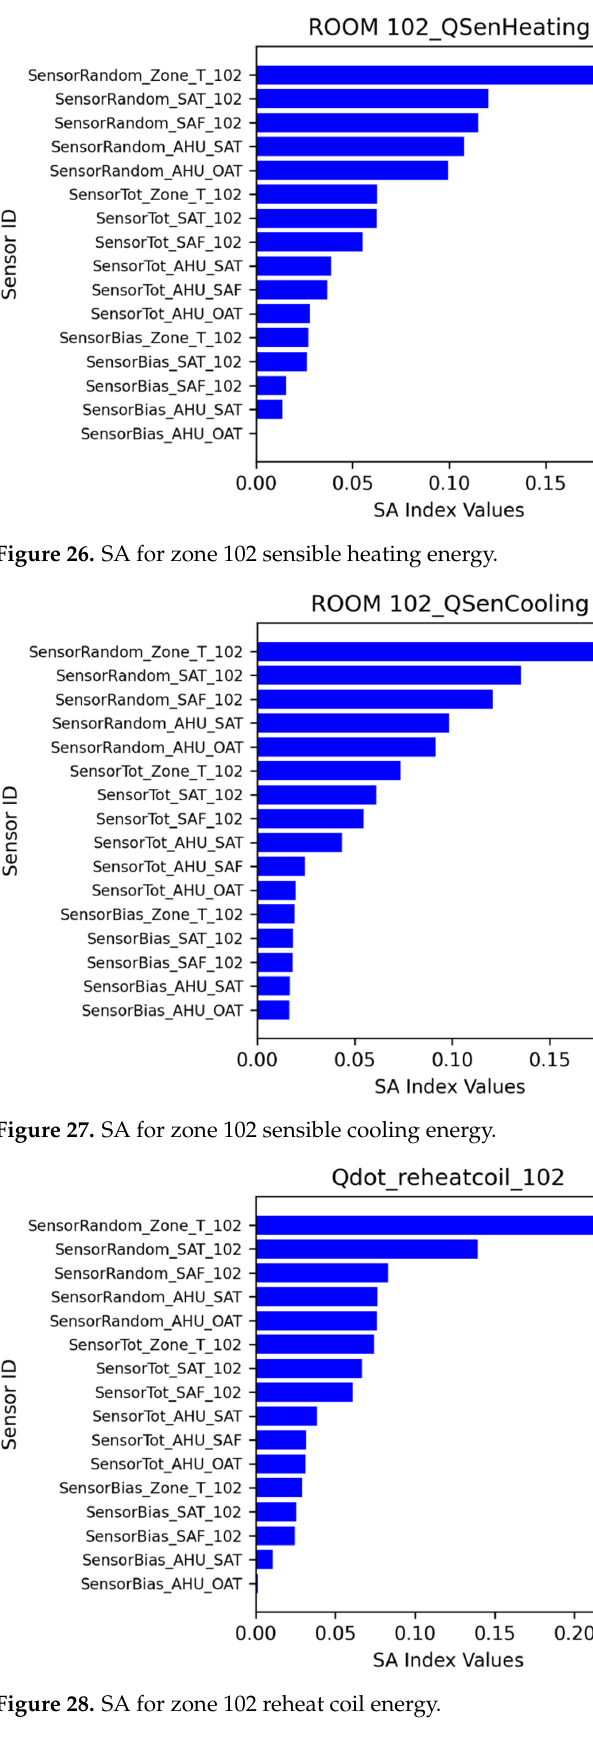
Figure 25. SA for zone 102 air temperature.